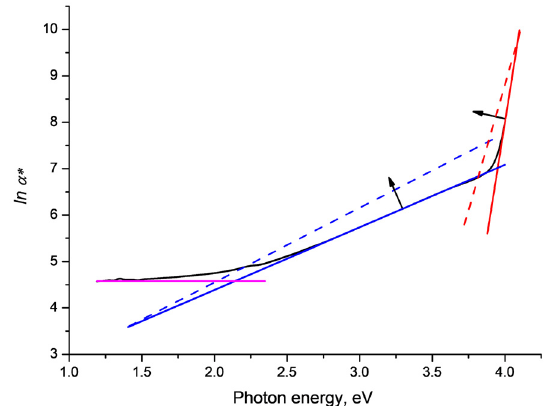
Figure 1. Linear approximations to the observed red shift of the absorption edge in PET films under SHI irradiation. Red and blue lines correspond respectively to the Urbach lines in the high-frequency UV and mid-frequency visible parts of the spectrum. Dotted lines and arrows show the general trend of rotation of these lines as the SHI fluence increases. The magenta line is an approximation in the low-frequency near-IR part of the spectrum where transmission is only very weakly dependent on the SHI fluence.